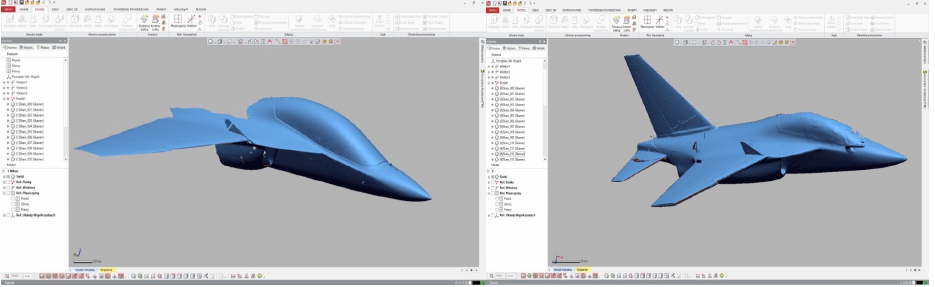
Figure 4. Example of registration process (scan matching) of individual point clouds (from left): the view of the right front and right part of the scan of the M-346 aircraft model.